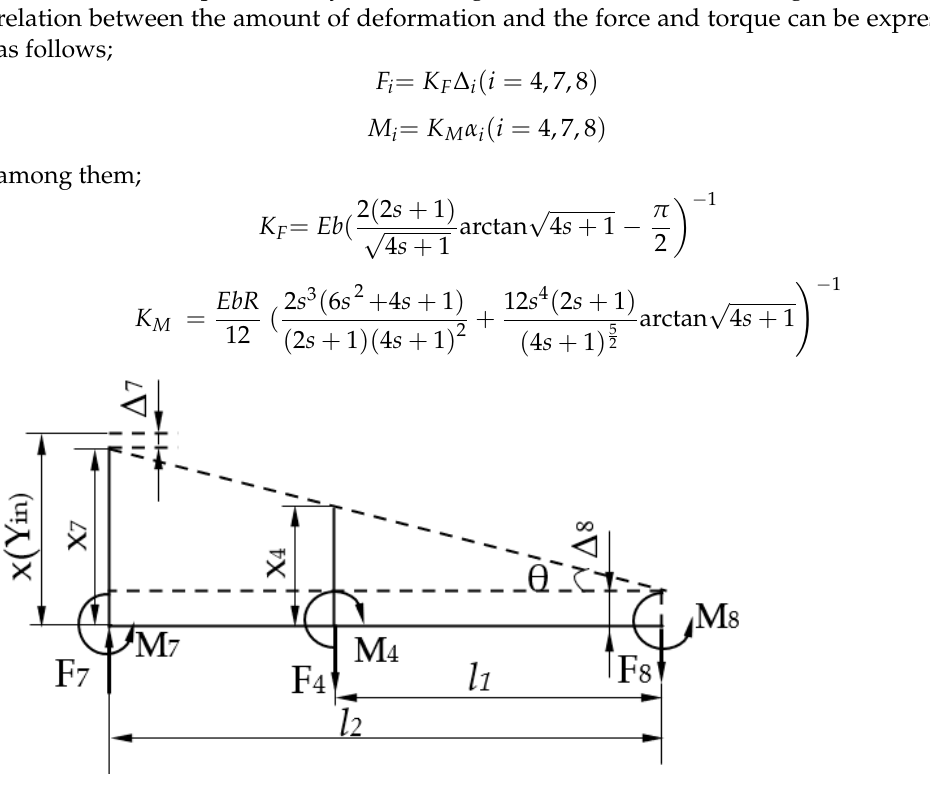
Figure 6. The geometry model of the mechanism with reduction ratio calculation.